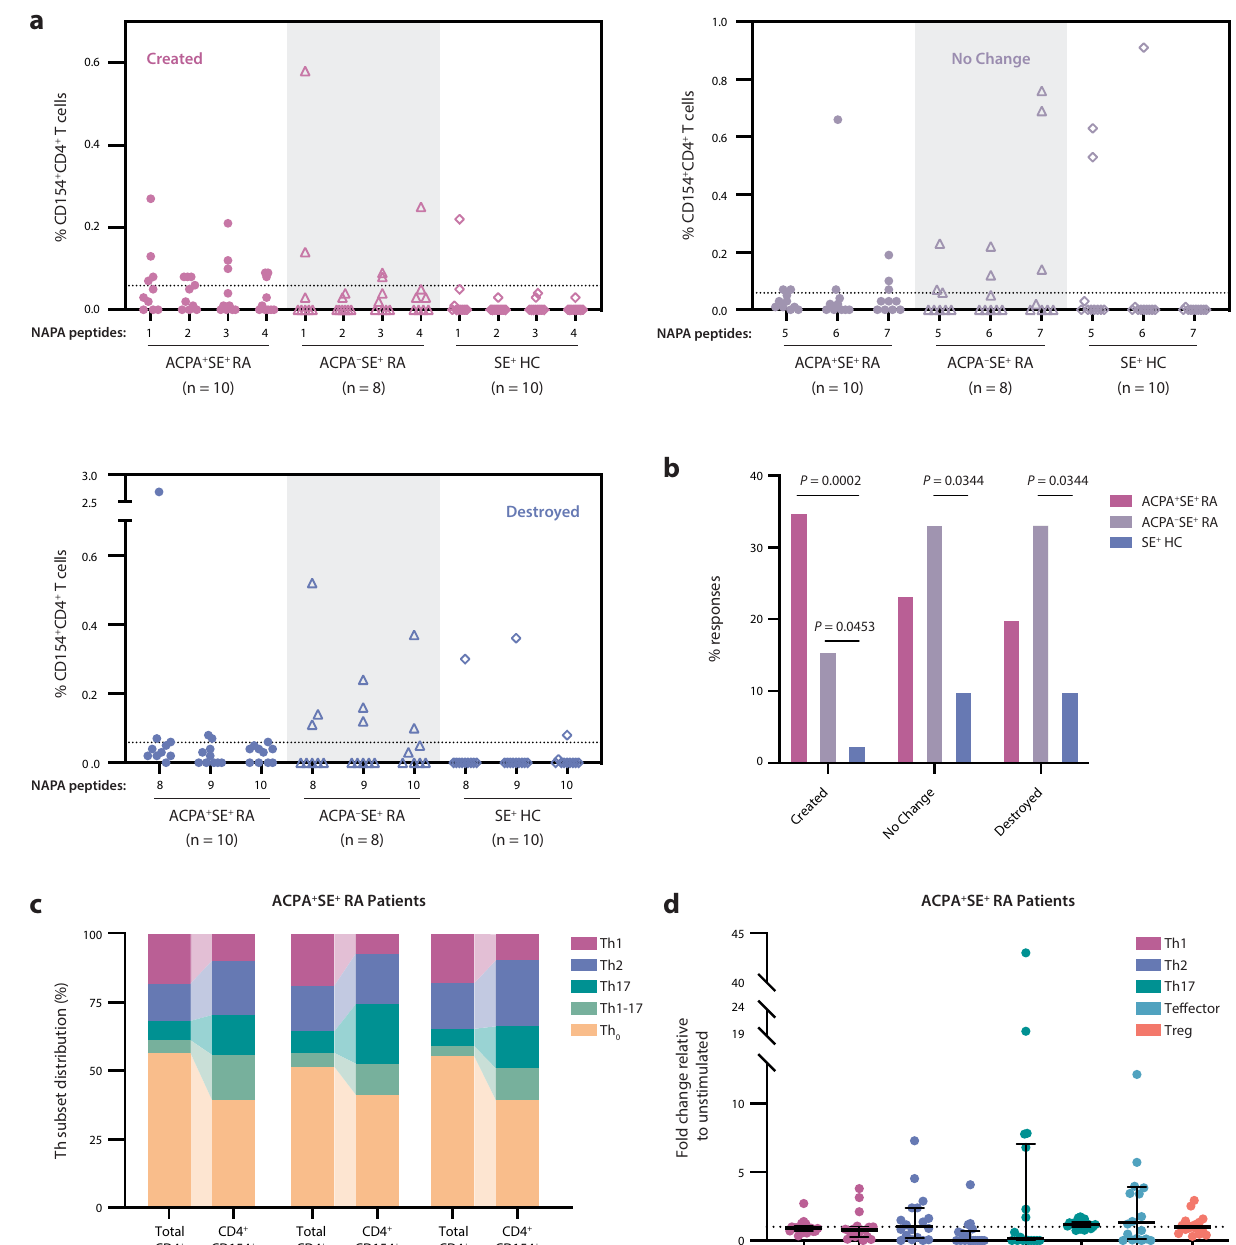
Fig. 6 | Unmodi fi ed, citrullination-dependent epitopes stimulate ACPA + SE + RA patient CD4 + T cells more robustly than native antigen – derived epitopes. a PBMCs from ACPA + SE + RA patients ( n =10), ACPA – SE + RA patients ( n =8), and SE + healthy controls ( n =10) were stimulated with created peptides (1 – 4), no change peptides (5 – 7), and destroyed peptides (8 – 10) derived from NAPA (Fig. 5a). Per- centage of CD154 + CD4 + T-cell response to each peptide is shown. b Percentage of potential T-cell responses (where the number of potential T-cell responses were de fi ned as total patients per group multiplied by the total peptides per group) is